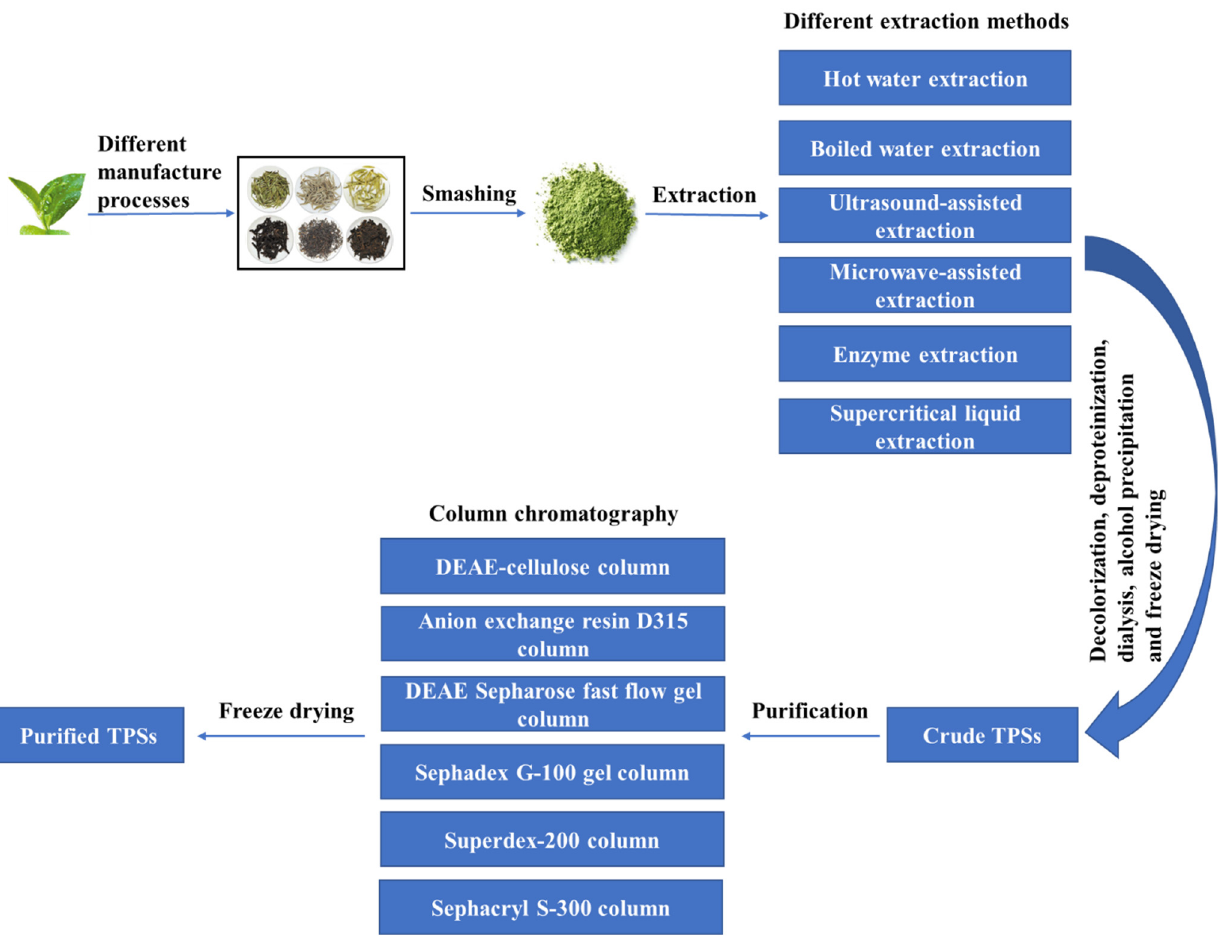
Figure 2. A schematic diagram of extraction and purification of TPSs.